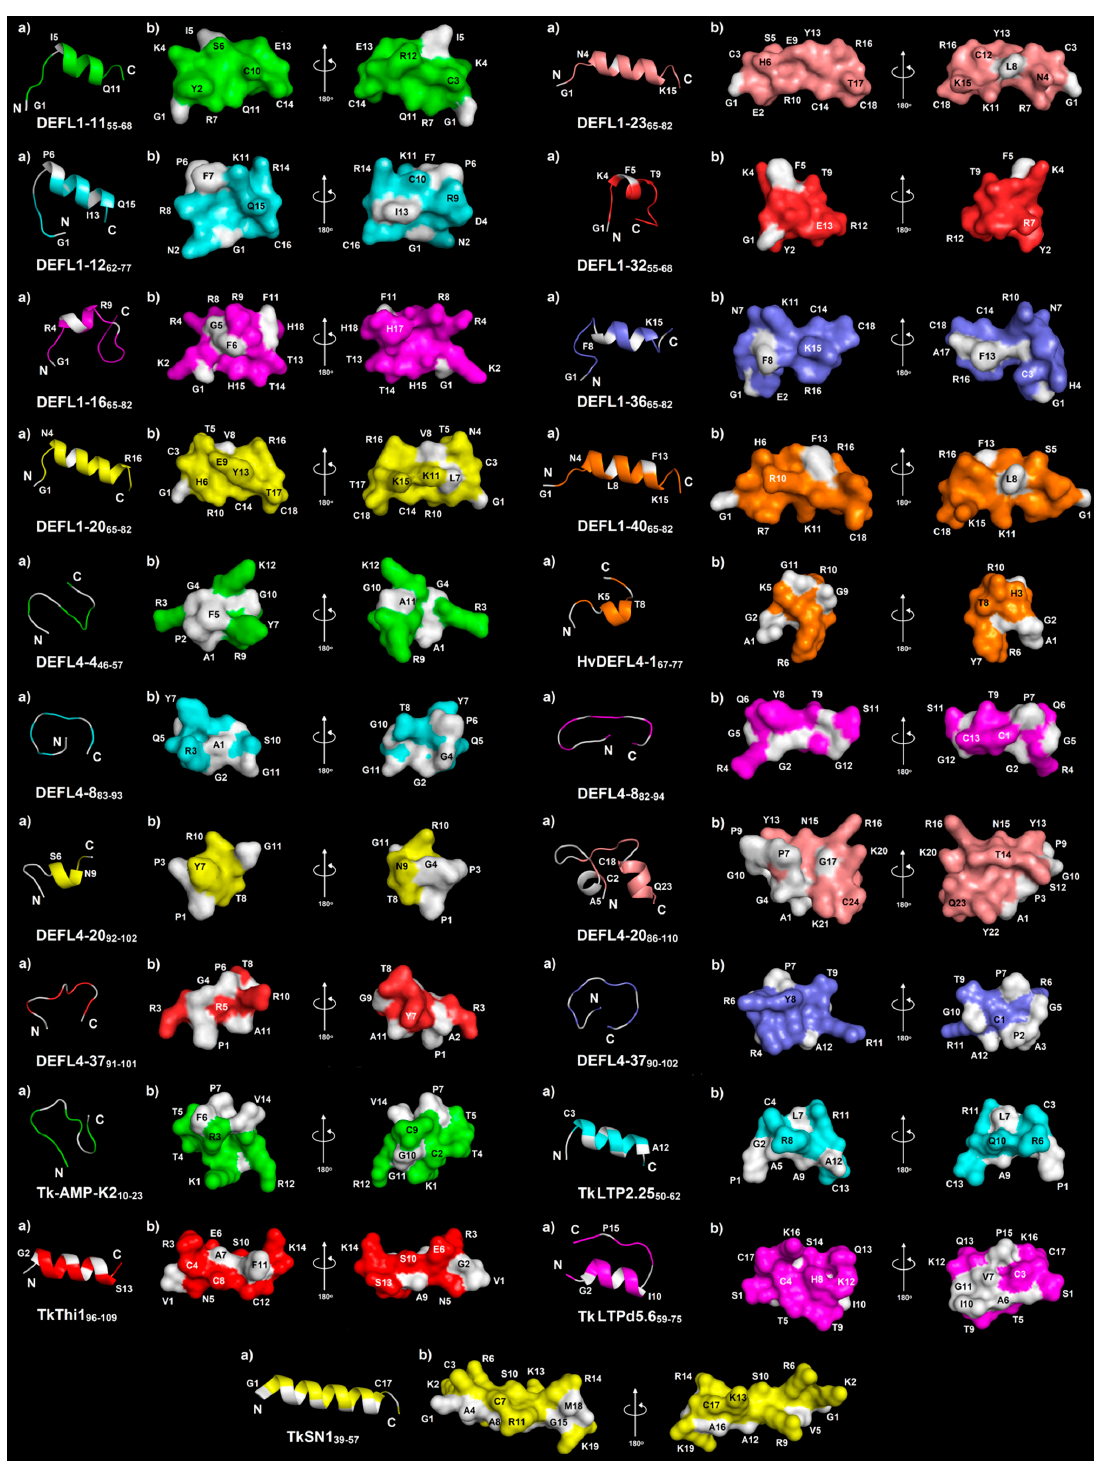
Figure 2. 3D molecular modeling of synthetic peptides: ( a ) spatial structure (ribbon representation); ( b ) surface structure. N- and C-termini are marked with N and C, respectively. Non-polar residues are shown in white, polar residues are colored. Modeling was performed using PEP-FOLD3 [25].